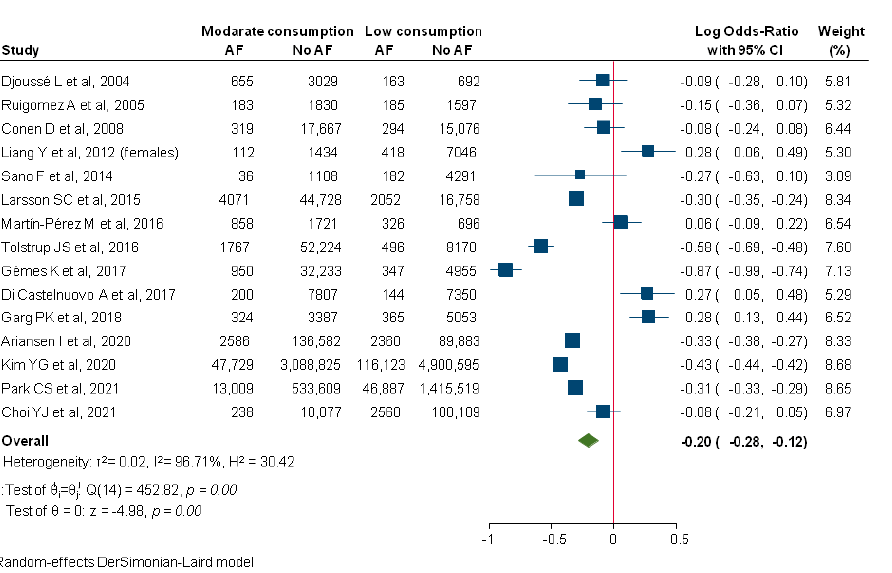
Figure 3. Comparison between moderate and low alcohol consumption regarding incident AF. AF, Atrial Fibrillation.